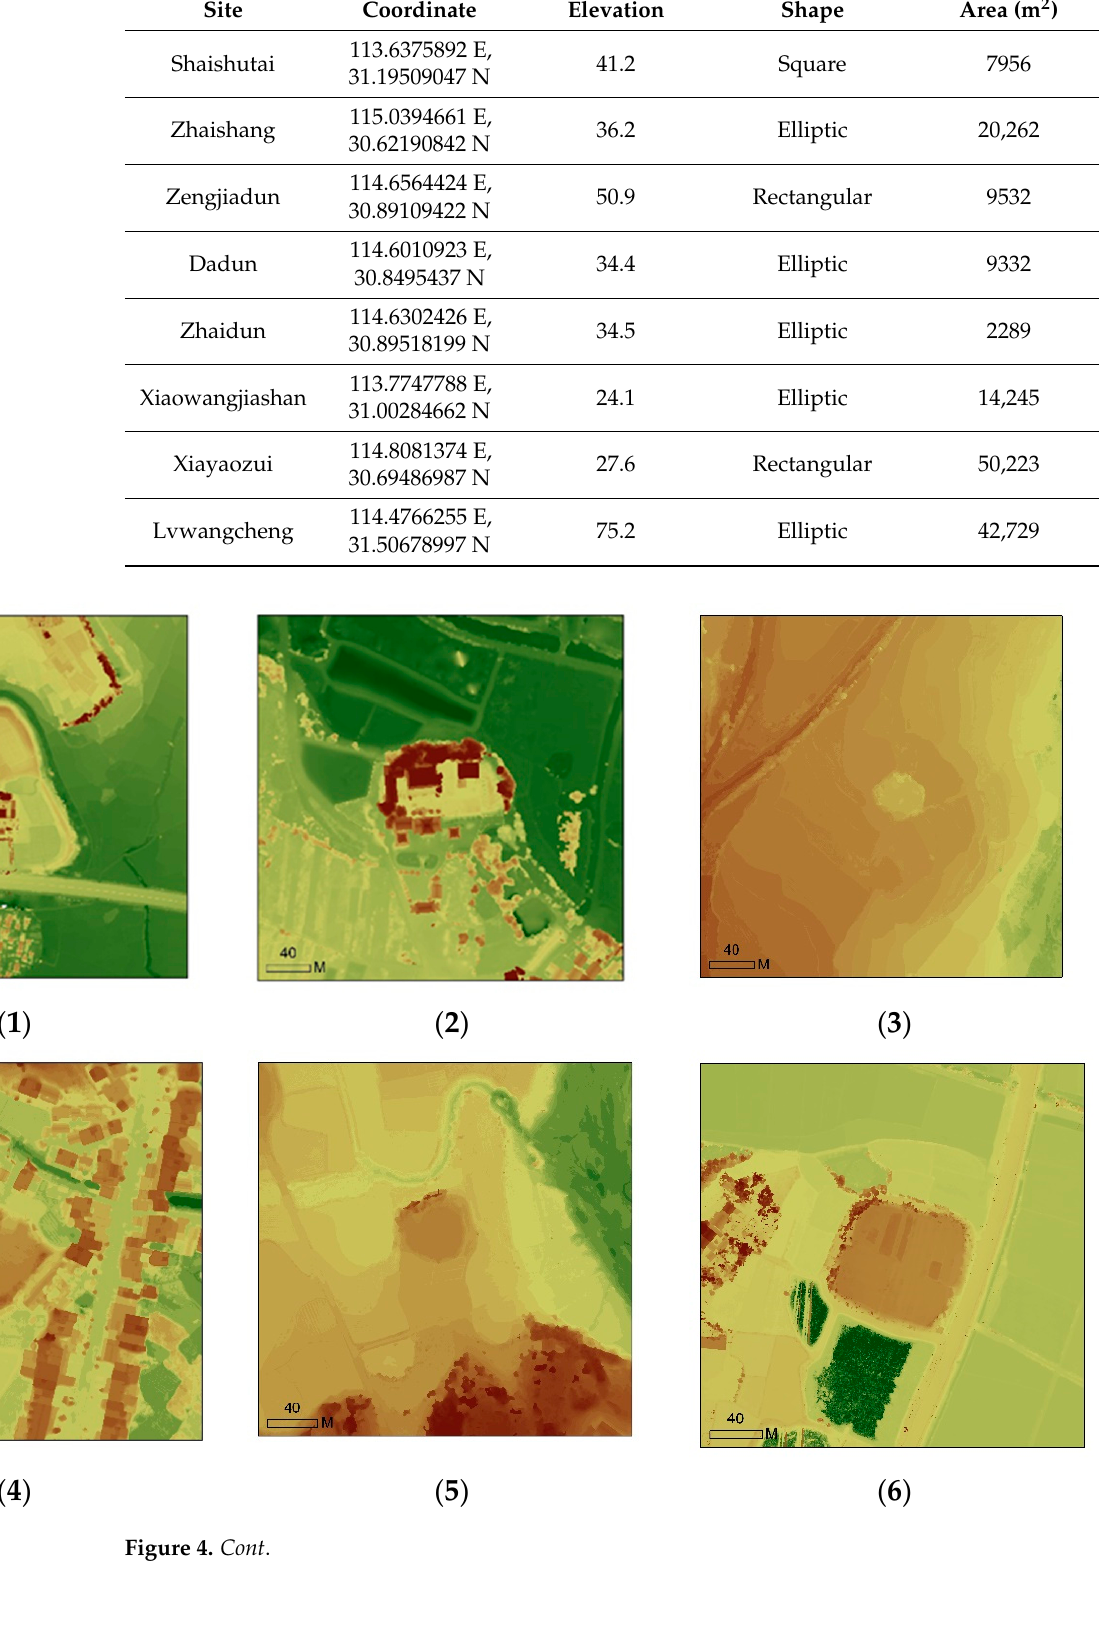
Table 1. Cont. Site Coordinate Elevation Shape Area (m 2 )